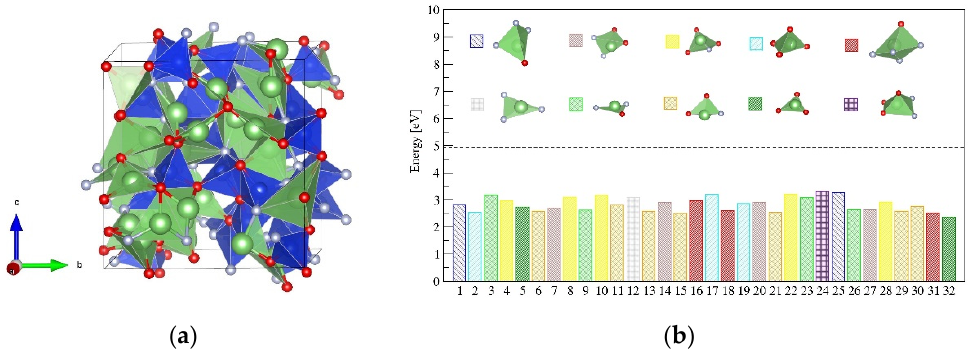
Figure 5. ( a ) The disordered structure of amorphous-LiSiON frozen at 300 K, in which the green, blue, red, and gray spheres represent Li, Si, O, and N atoms, respectively. ( b ) The formation energy for each of the Li vacancy in amorphous-LiSiON and the coordination environment of each Li site. The value for creating one Li vacancy in crystalline α -LiSiON is indicated as a horizontal dotted line for comparison.